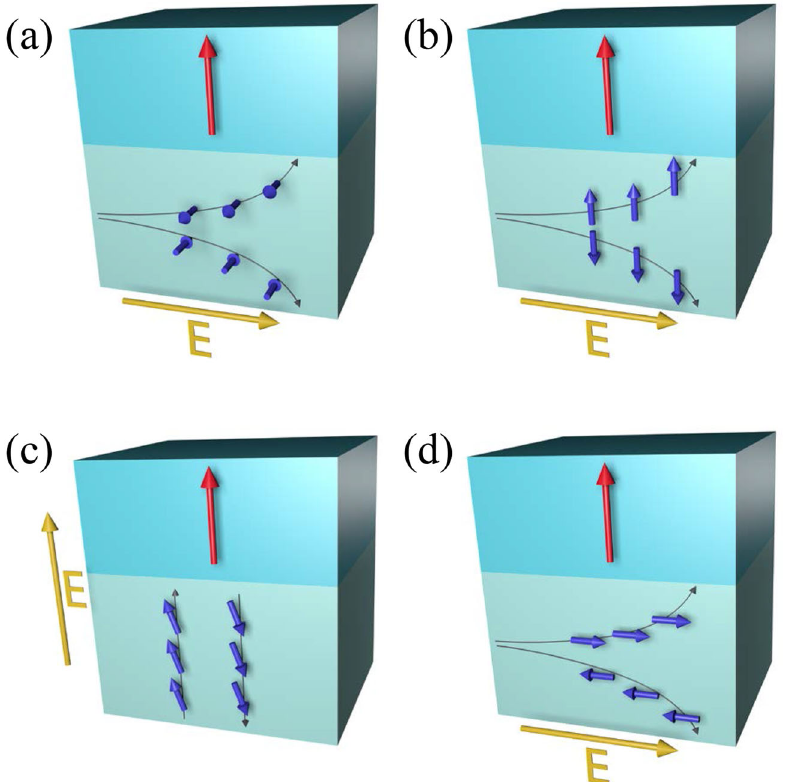
Fig. 4 Heterojunction of ferromagnets and non-magnets with four types of spin current included in this database. The top and bottom layers are ferromagnetic and non-ferromagnetic, respectively. a Traditional SHE with the spin polarization of the spin current perpendicular to both the spin current and the charge current. b Spin current fl owing in the direction transverse to the electric fi eld with the spin polarization orientated in the direction of the fl ow. c Longitudinal spin current fl owing in the direction of the electric fi eld. d Spin current fl owing in the direction transverse to the electric fi eld with the spin polarization existing along the direction of the electric fi